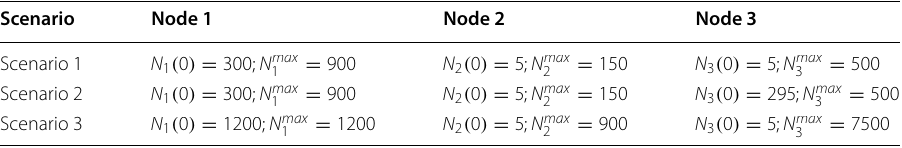
Table 5 Initial conditions and node maximal capacities for the three scenarios under study